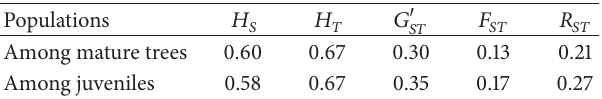
Table 3: Genetic variation within and among populations of M. thunbergii .